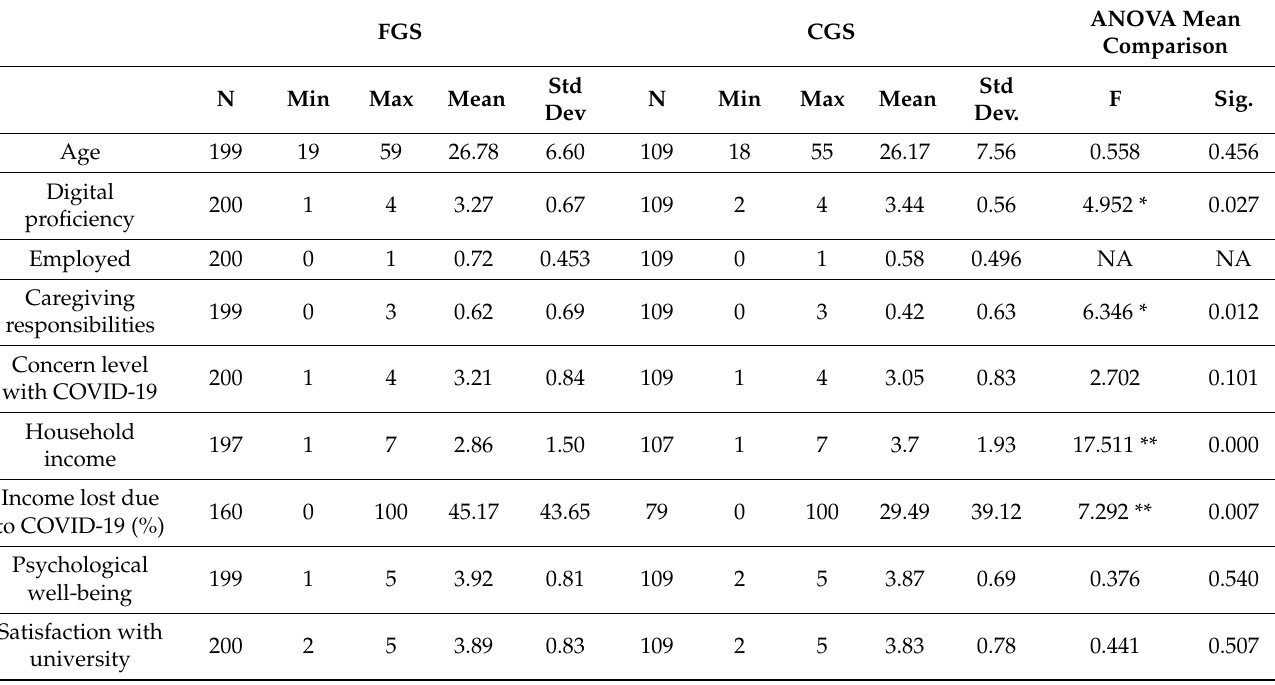
Table 2. Descriptive statistics grouped by FGS and CGS.